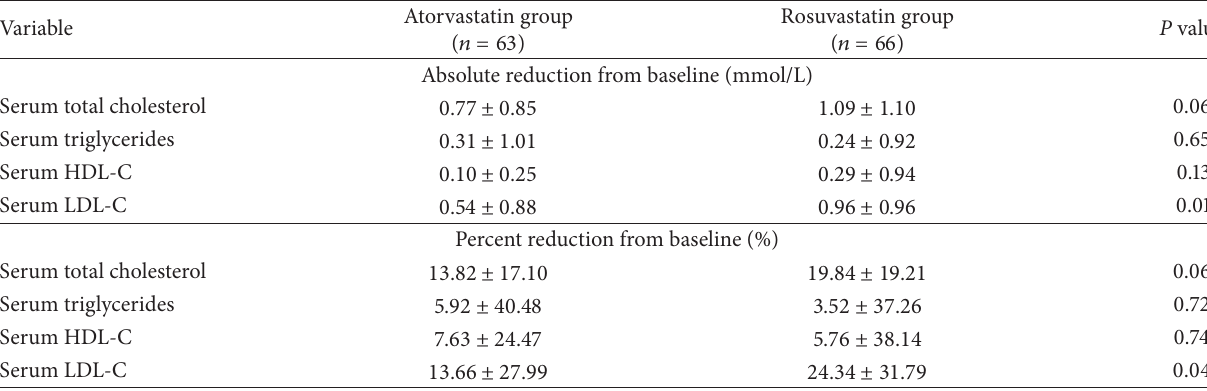
∗ P values refer to the comparison between treatment